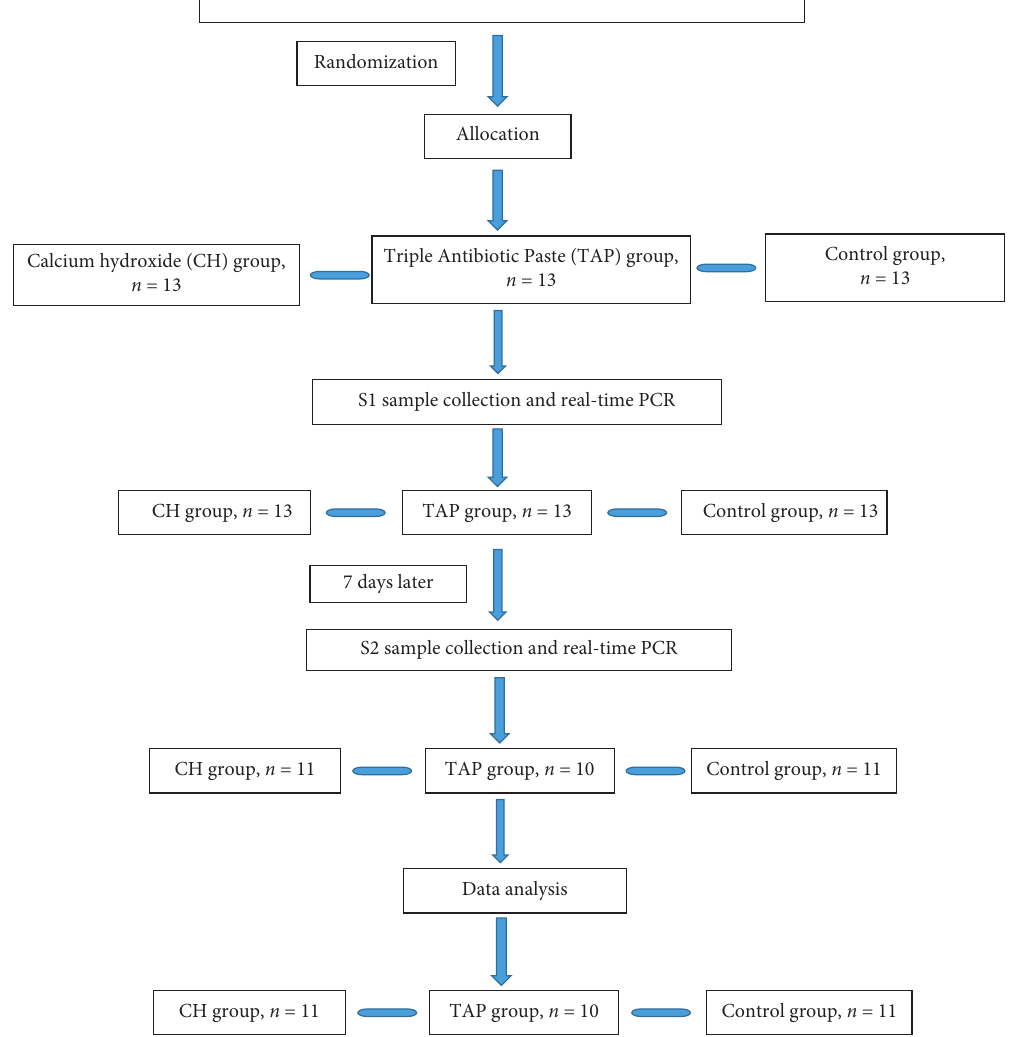
Figure 1: Diagram of the clinical procedure of the